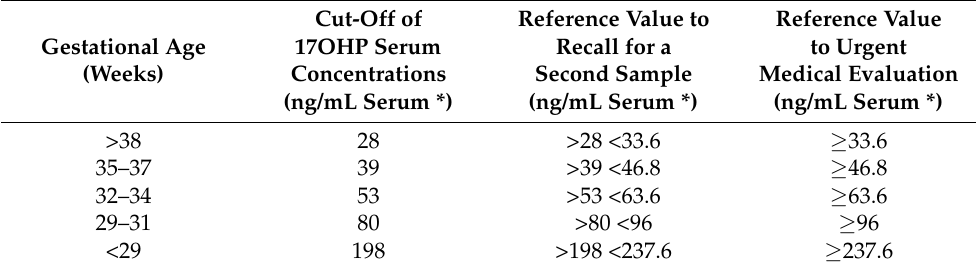
Table 1. Cut-off values of 17-hydroxyprogesterone (17OHP) in DBS.